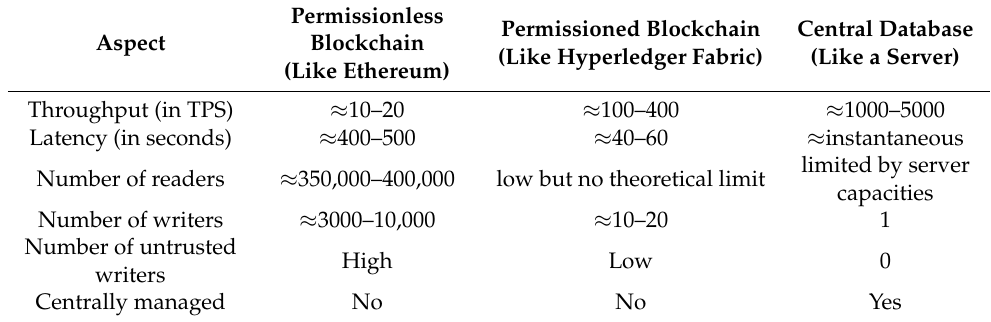
Table 1. Table inspired by [12,18] showing differences between blockchains and central databases. Permissionless Permissioned Blockchain Central Database Aspect Blockchain (Like Hyperledger Fabric) (Like a Server) (Like Ethereum) Throughput (in TPS) ≈ 10–20 ≈ 100–400 ≈ 1000–5000 Latency (in seconds) ≈ 400–500 ≈ 40–60 ≈ instantaneous limited by server Number of readers ≈ 350,000–400,000 low but no theoretical limit capacities Number of writers ≈ 3000–10,000 ≈ 10–20 1 Number of untrusted High Low 0 writers Centrally managed No No